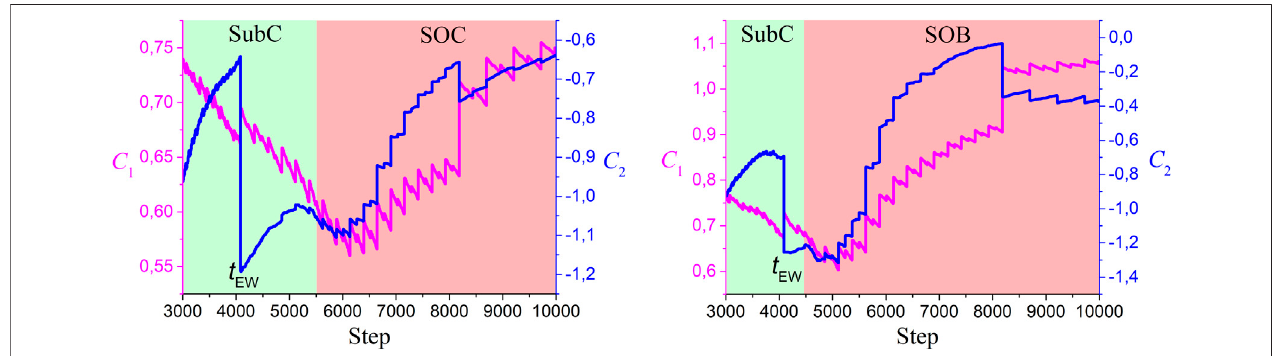
FIGURE 2 | Time series of the log cumulants for the standard (left) and facilitated (right) BTW